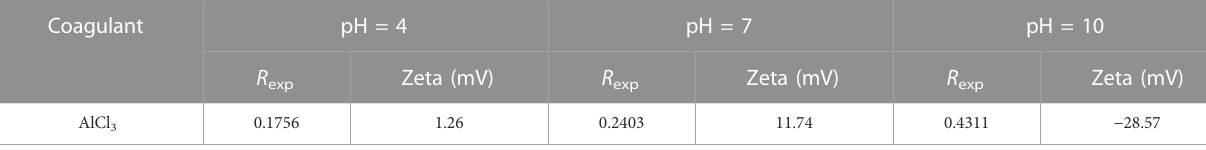
TABLE 1 Comparison of R exp of 38 dyes by AlCl 3 and the zeta potentials of AlCl 3 at different pH values.